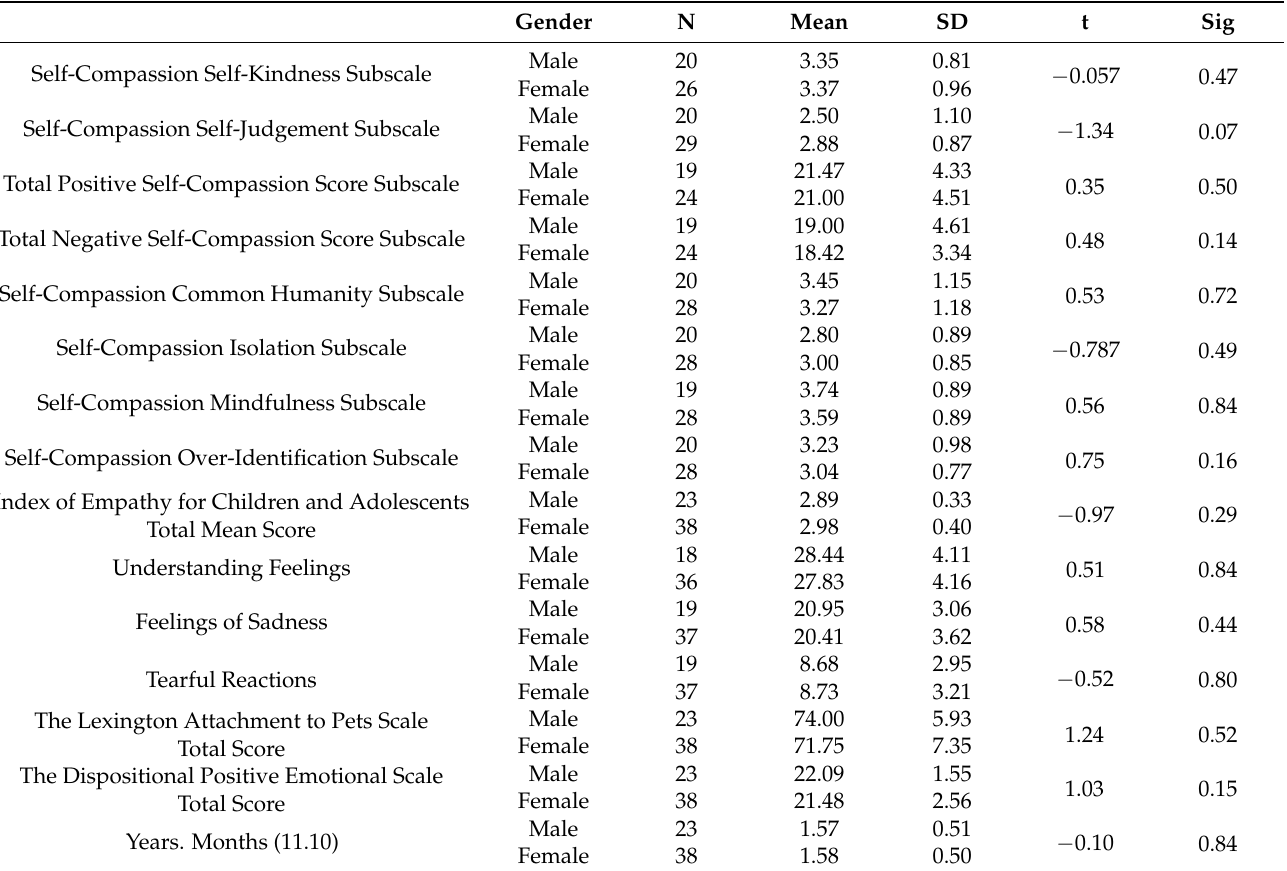
Table 1. Descriptives and gender differences for main test